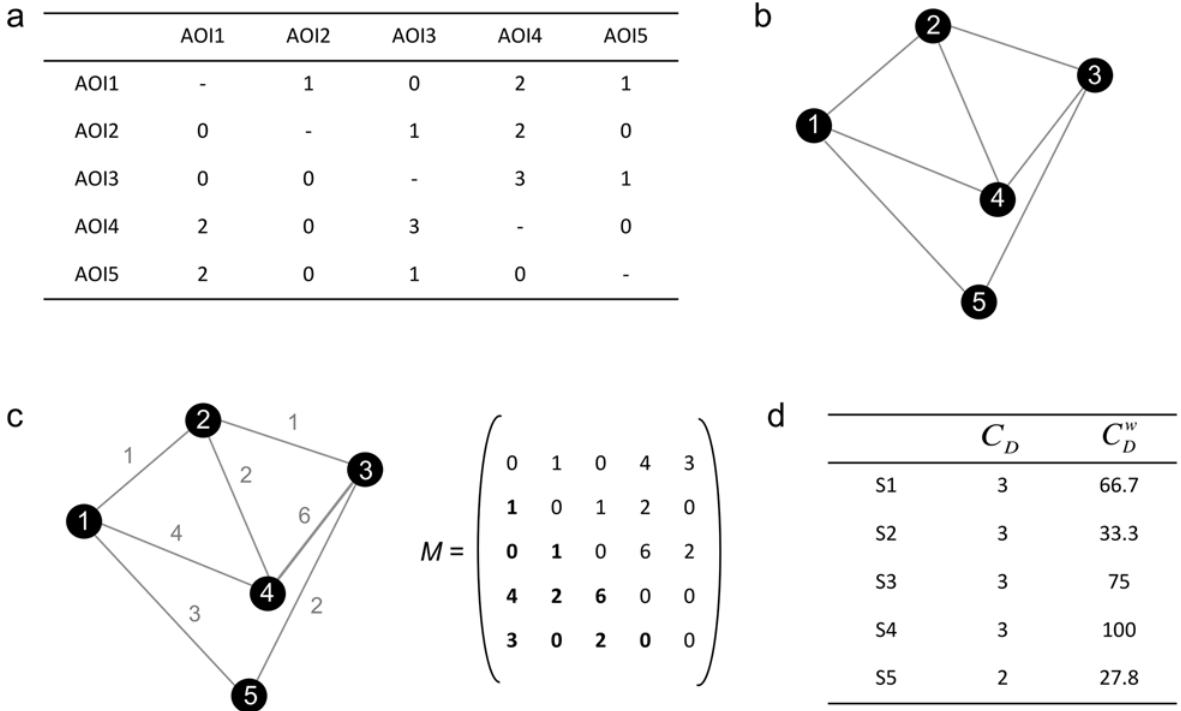
Fig 1. Approach based on transition matrices. a) A fictitious 5 x 5 transition matrix, b) The corresponding undirected network with nodes S1, S2, S3, S4, S5 and links (i.e. transitions) between these nodes, c) The corresponding weighted undirected network with the number of links between pairs of nodes on the left, and weighted adjacency matrix M on the right d) Degree centrality for each node in the network.